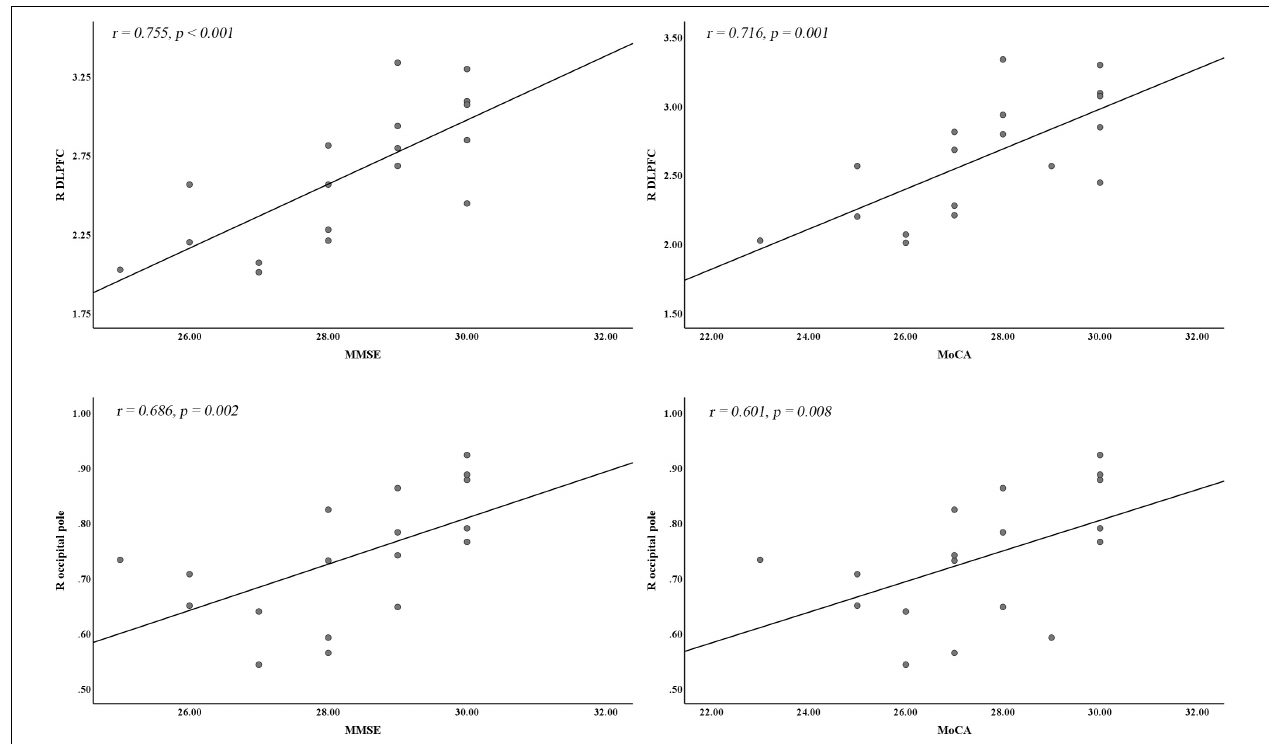
FIGURE 2 | Correlation analysis between significantly different CBF or VBM clusters and cognitive and clinical variables. DLPFC, dorsal lateral prefrontal cortex; MMSE, Mini-Mental State Examination; MoCA, Montreal Cognitive Assessment; R, right